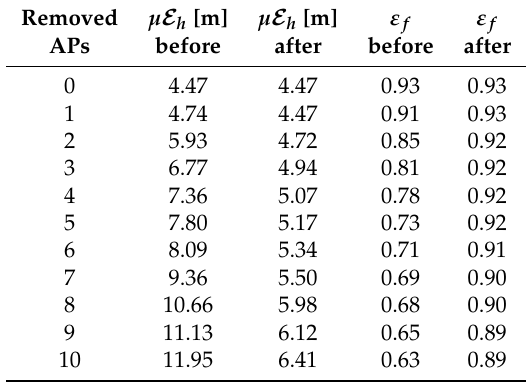
Table 2. Results of the localisation for removed APs: before and after update. Removed µ E h [m] µ E h [m] ε f ε f APs before after before after